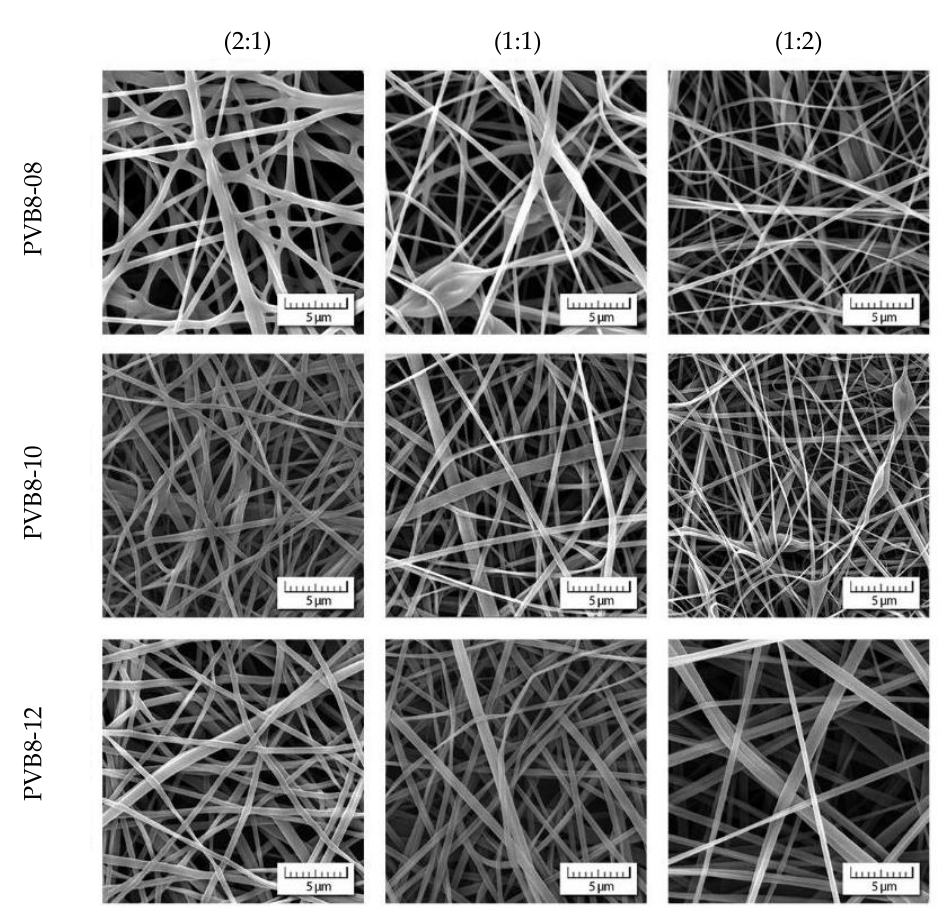
Figure 5. Morphology of nanofibrous webs of recycled and virgin PVB (various concentrations in ethanol).